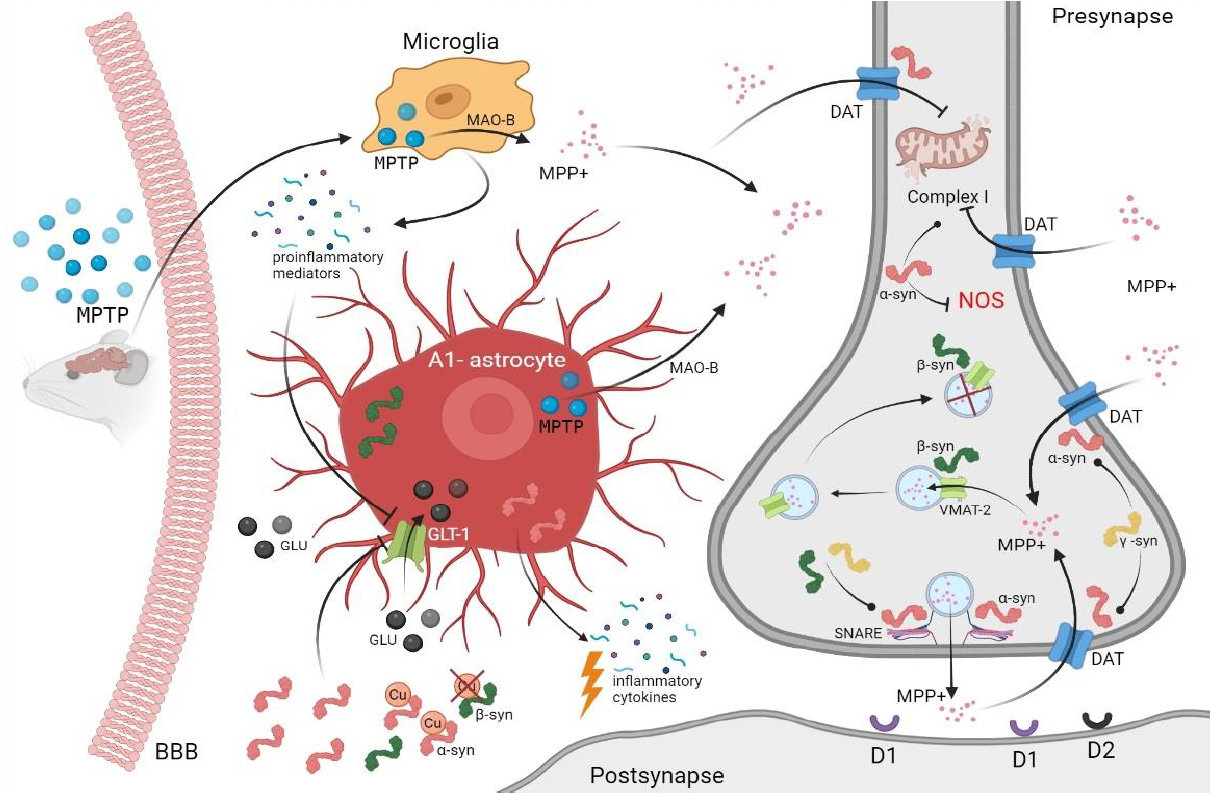
Figure 1. The role of synucleins in the mechanisms of SNpc DA neurons during MPTP-induced parkinsonism. Key regulatory factors include the regulatory activity of all synucleins toward the presynaptic membrane of the dopamine transporter (DAT); increased DAT/VMAT-2 ratio and SNARE assembly due to the presence of alpha-synuclein and support from other members of the synuclein family; the inability of beta-synuclein in the presence of alpha- and gamma-synucleins to potentiate VMAT-2-dependent MPP+ capture to further sequester these molecules; the involvement of alpha-synuclein in the neuroinflammatory response; and glutamate toxicity induced by glial cells. These, as well as other unexplored effects of alpha-synuclein binding and penetration into damaged mitochondria, may have a special effect on the MPTP-induced death of DA neurons. Created with BioRender.com (accessed on 2 November 2021).